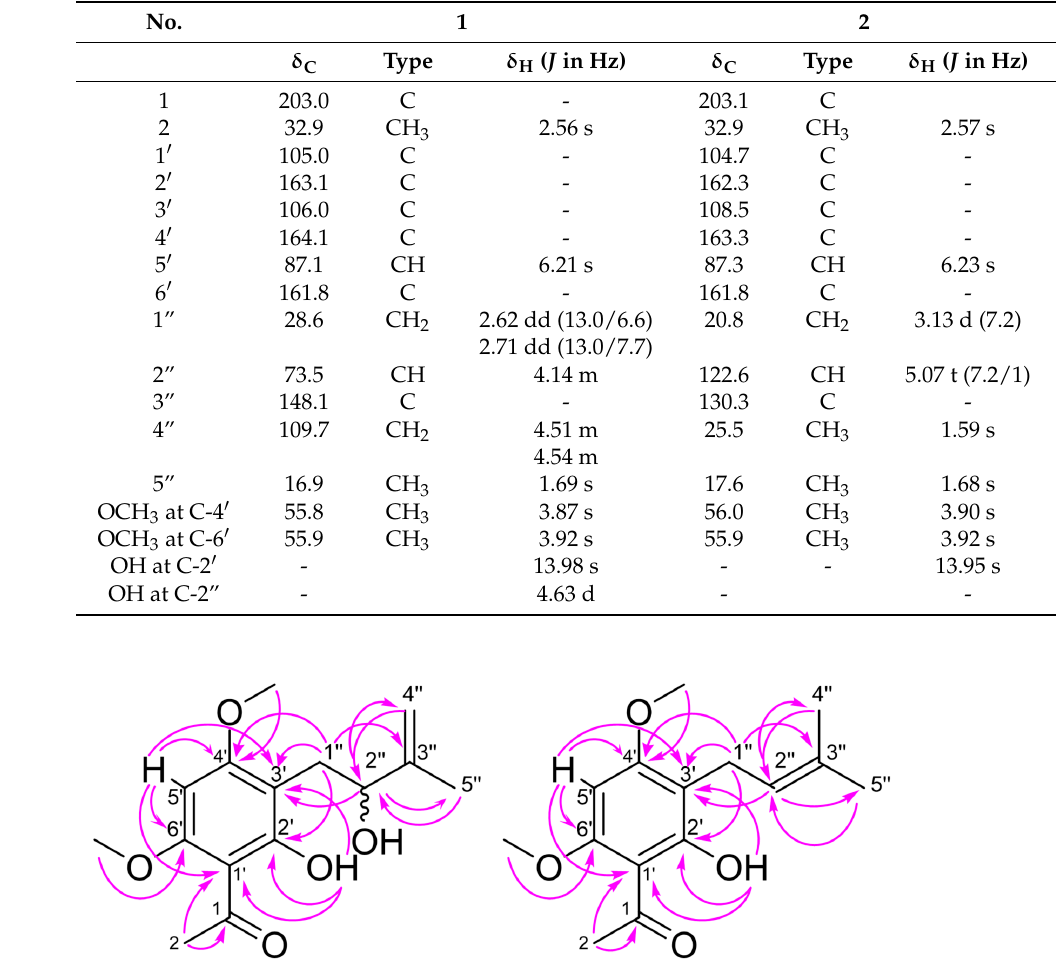
Table 1. 1 H- and 13 C-NMR data of 1 and 2 (600 and 150 MHz, δ in ppm, in DMSO- d 6 ).